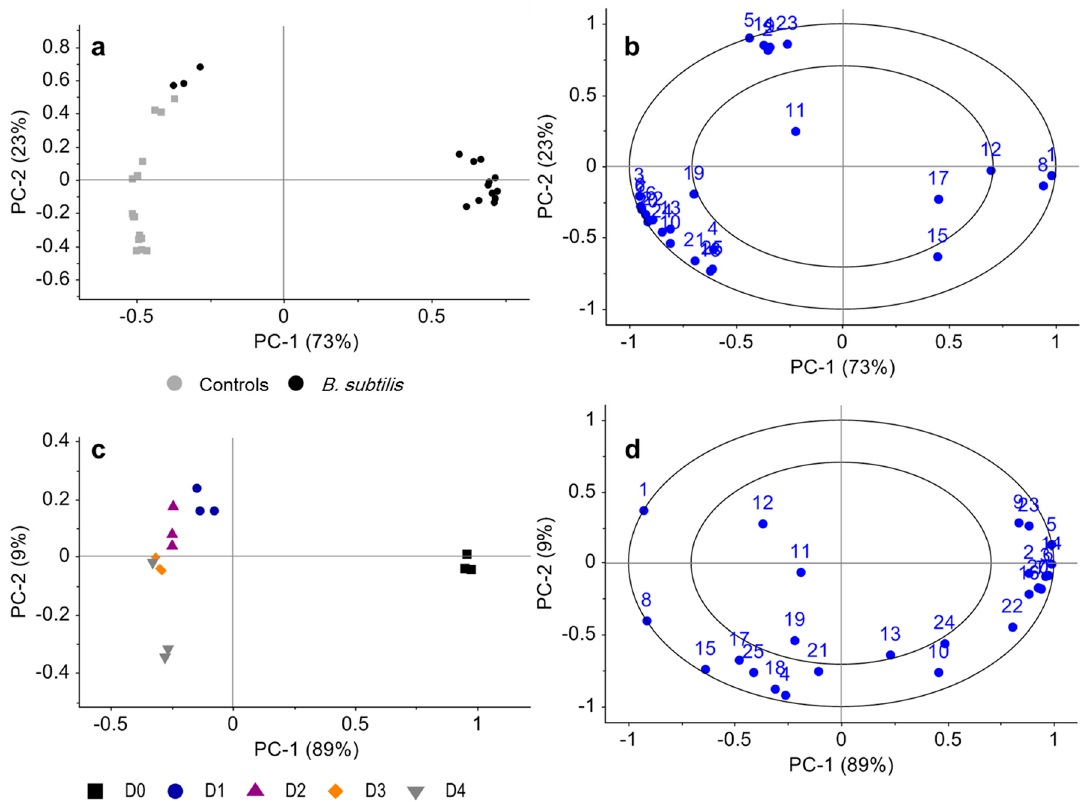
Figure 5. Principal component analysis (PCA) scores plots (left) and loadings plots (right) for data obtained from SPME Arrow profiling of Bacillus subtilis samples. For all control and bacterial samples, the PCA scores ( a ) and loadings ( b ) are shown on the top. For the bacterial samples with controls removed, the PCA scores ( c ) and loadings ( d ) are shown on the bottom. Number labels on both loadings plots correspond to compound identities listed in Table 1.